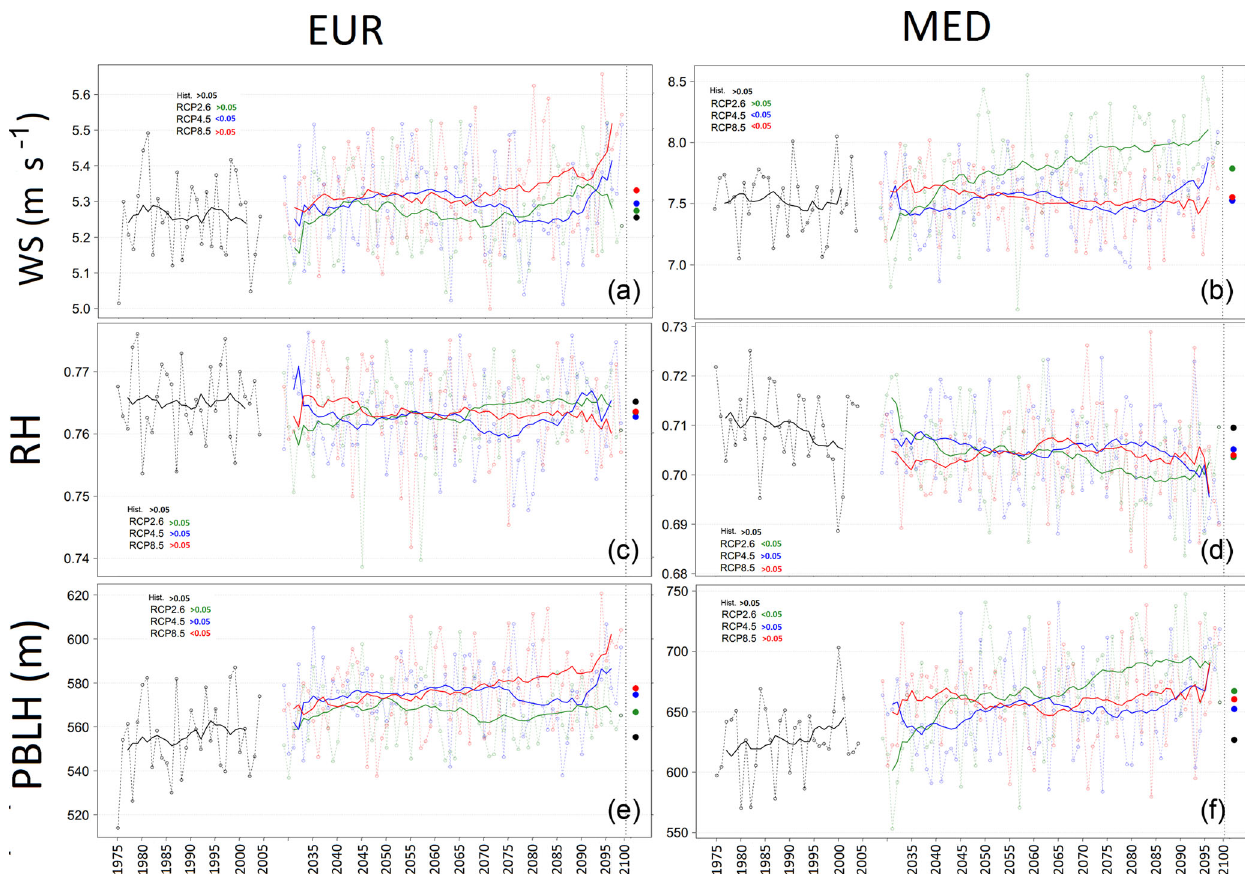
Figure 3. Time series of wind speed (WS; ms − 1 ; a, b ), relative humidity (RH; c, d ) and planetary boundary layer height (PBLH; in meters; e, f ) for EUR (a, c, d) and MED (b, d, f) subdomains for all climate change scenarios as well as historic simulations. The average for each scenario is shown by the corresponding point on right side of the plot. The solid lines show the rolling average of 30 years for future scenarios and 20 years for historic scenarios. Numbers in the legend show the p value of the linear regression for each scenario.